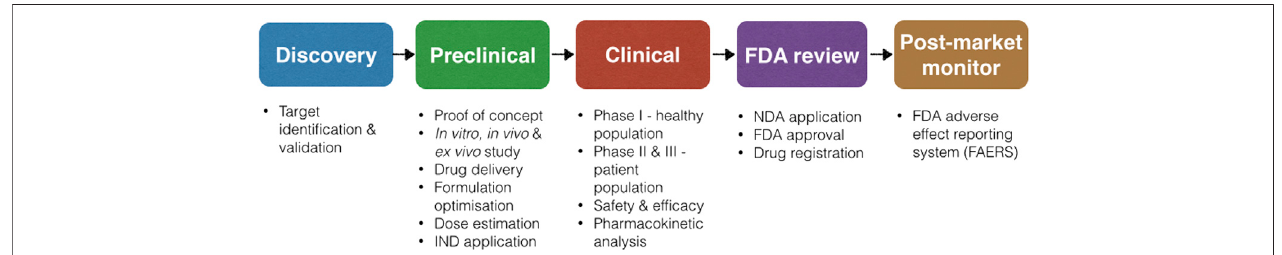
FIGURE 1 | Process of new drug development according to the FDA, adopted from (Lipsky and Sharp, 2001).